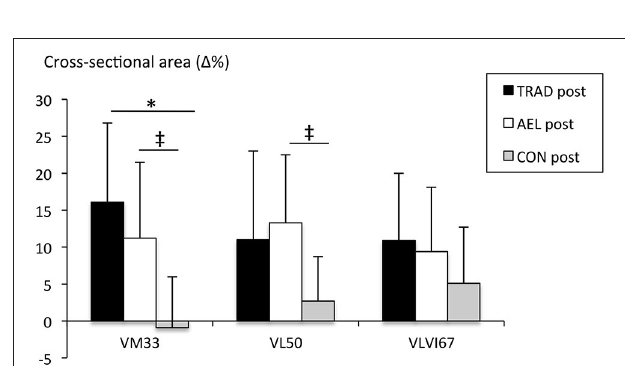
FIGURE 4 | Relative changes (mean ± SD ) in vastus medialis, vastus lateralis and vastus lateralis+intermedius cross-sectional area at 33, 50 and 67% femur length, respectively. * p < 0.05 between intervention and control groups. ‡ p < 0.1 between intervention and control